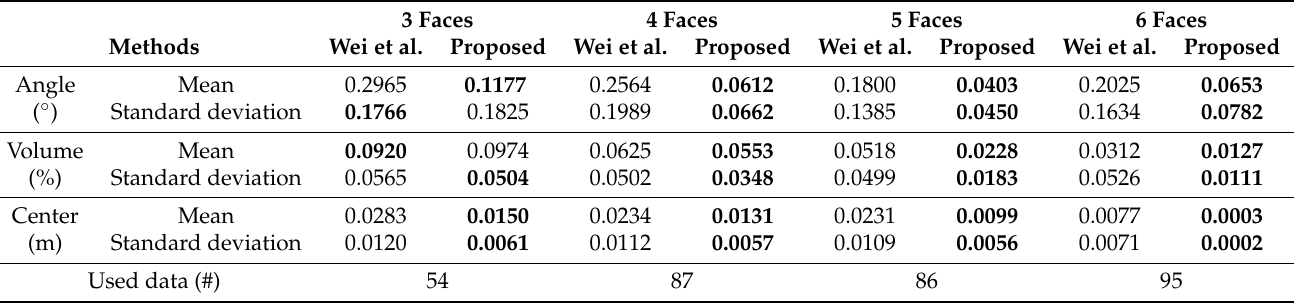
Table 3. Error mean and standard deviation with same data.